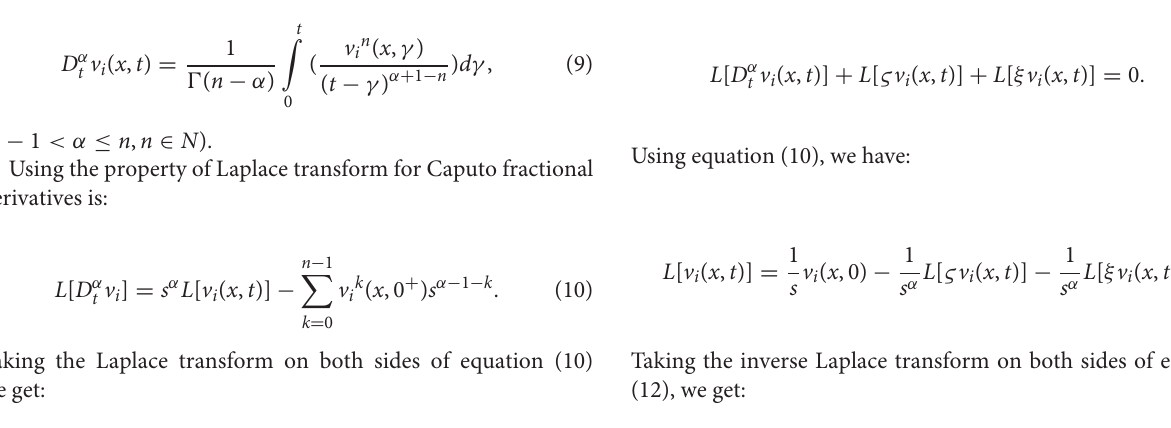
TABLE 1 | Second-order DJ solution for u ( x , t ) in comparison with ADM, VIM, and OHAM solutions at α